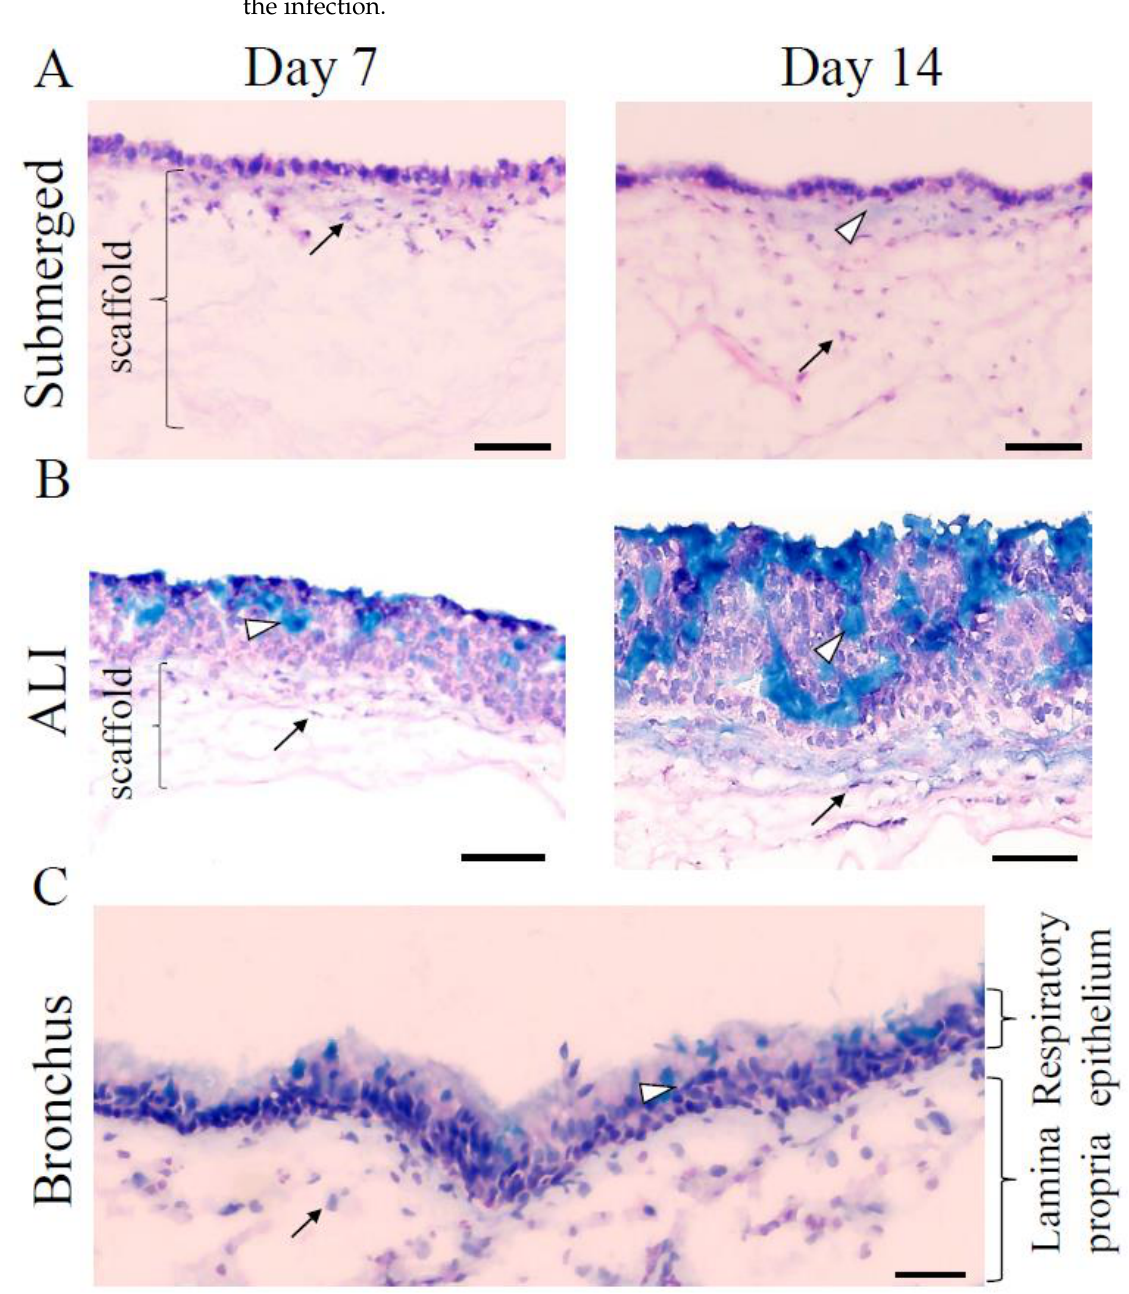
Figure 1. Three-dimensional (3D) tissue engineering produces well-developed 3D airway tissue models within 14 days. ( A ) Alcian blue staining of 3D submerged models cultivated for 7 ( left ) and 14 ( right ) days, respectively. White arrowheads point to a modicum of mucus indicated by the light blue color. ( B ) Alcian blue staining of ALI models cultivated for 7 ( left ) and 14 ( right ) days, respectively, showed the cumulative thickness of the mucus layer (see white arrowheads). Black arrows indicate human primary fibroblasts (hpF) within the collagen scaffold that is marked with a bracket. Three independent experiments were performed. ( C ) Alcian blue staining of the native bronchial epithelium shows the presence of mucus (light blue color indicated by white arrowheads) and subepithelial cells (black arrow) The bronchus was washed before cryo-preservation. ALI: air-liquid interface. Scale bars represent 100 µm.